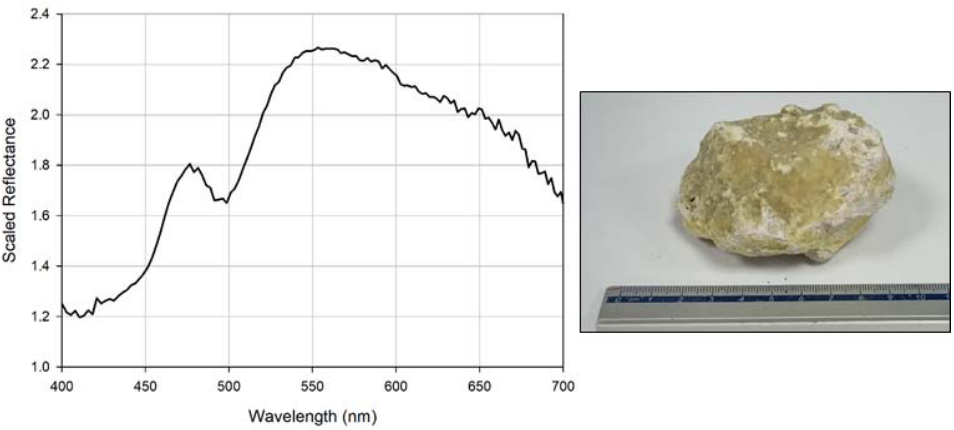
Figure 8. Observed spectral reflectance for the sulphur sample ( right ); note the significant increase in reflectance observed from ca. 500 nm in the spectral data ( left ). Scaled reflectance is representative of R Target in Equation (1).